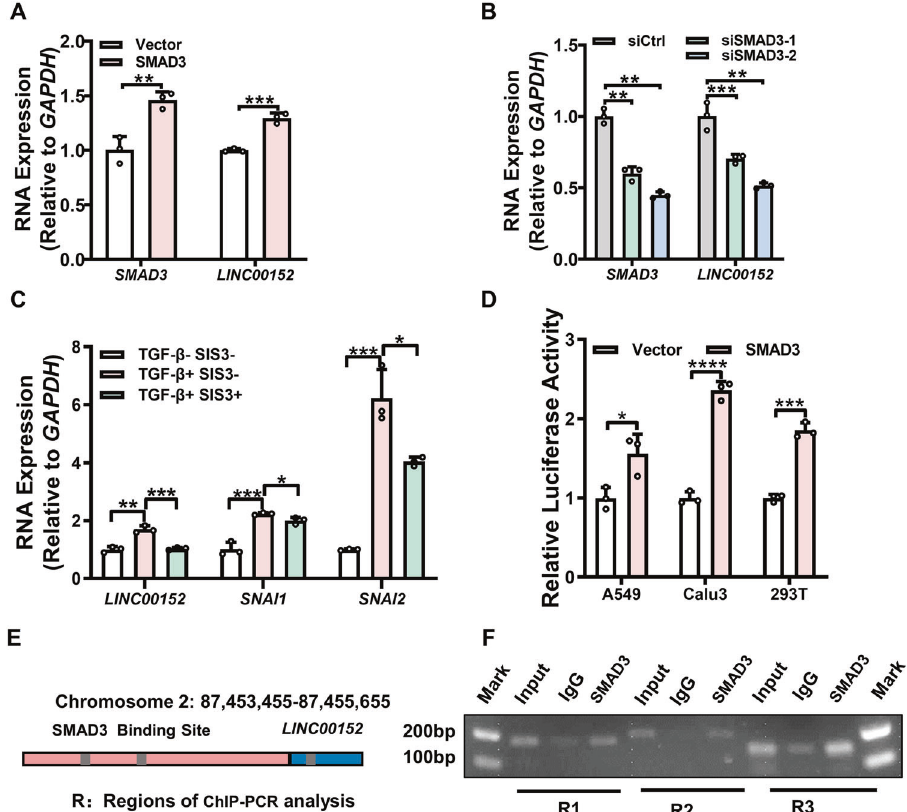
inhibitor SIS3. D Dual-luciferase reporter assays detected the activity of the LINC00152 promoter in the SMAD3-overexpressing A549, Calu3 and 293 T cells. Luciferase activity was normalized to Renilla. E Schematic illustrations showing the predicted locations of three SMAD3- binding sites in LINC00152 promoter. F ChIP assay using the speci fi c SMAD3 antibodies, then LINC00152 associated with three promoter regions was detected by PCR using speci fi c primers. Data have been presented as the mean ± SD of three independent experiments (** p < 0.01; *** p < 0.001; **** p < 0.0001. Student ’ s t